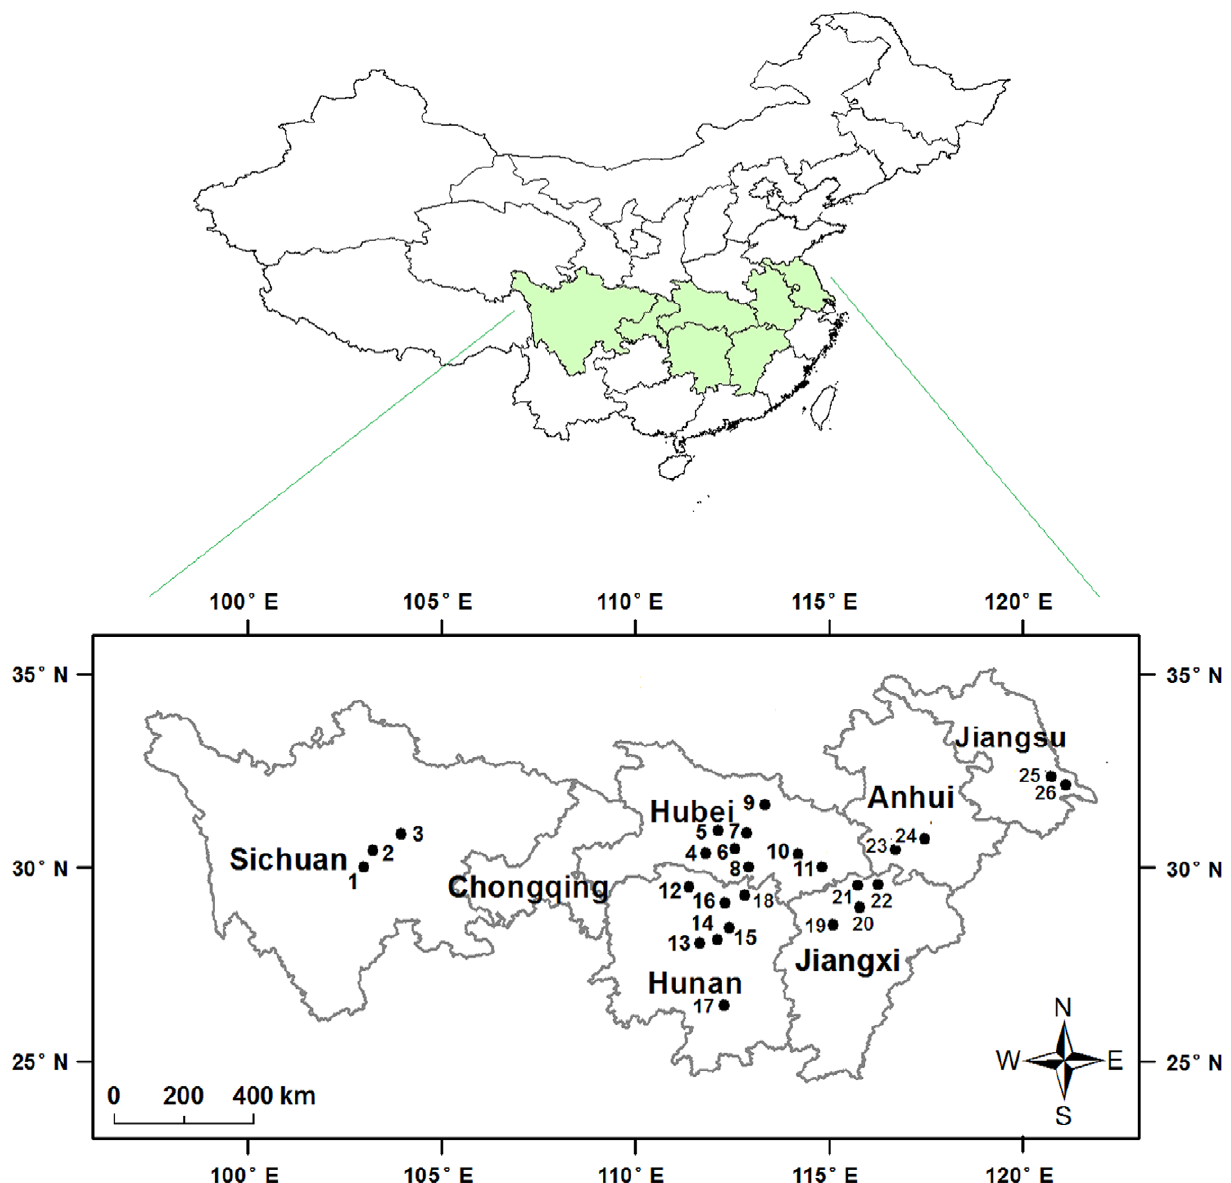
Figure 1. Sites for pink bollworm monitoring in China’s Yangtze River Valley.